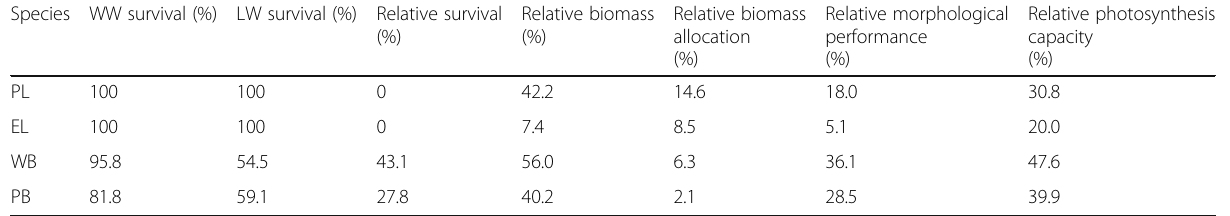
Table 1 Sensitivity of Prince Rupprecht ’ s larch (PL), eastern larch (EL), white birch (WB) and paper birch (PB) to water deficit Species WW survival (%) LW survival (%) Relative survival Relative biomass (%)